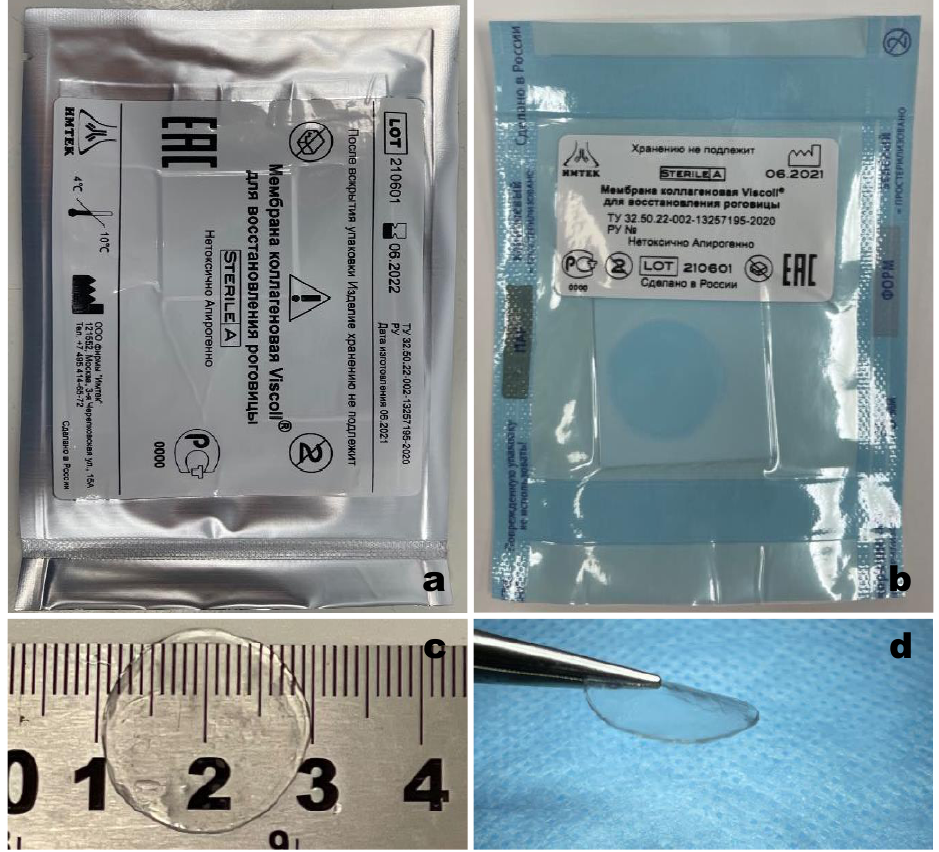
Figure 1. ( a ) Viscoll collagen membrane in vacuum packaging; ( b ) Viscoll collagen membrane in primary packaging; ( c , d ) views of the Viscoll collagen membrane ready for use.